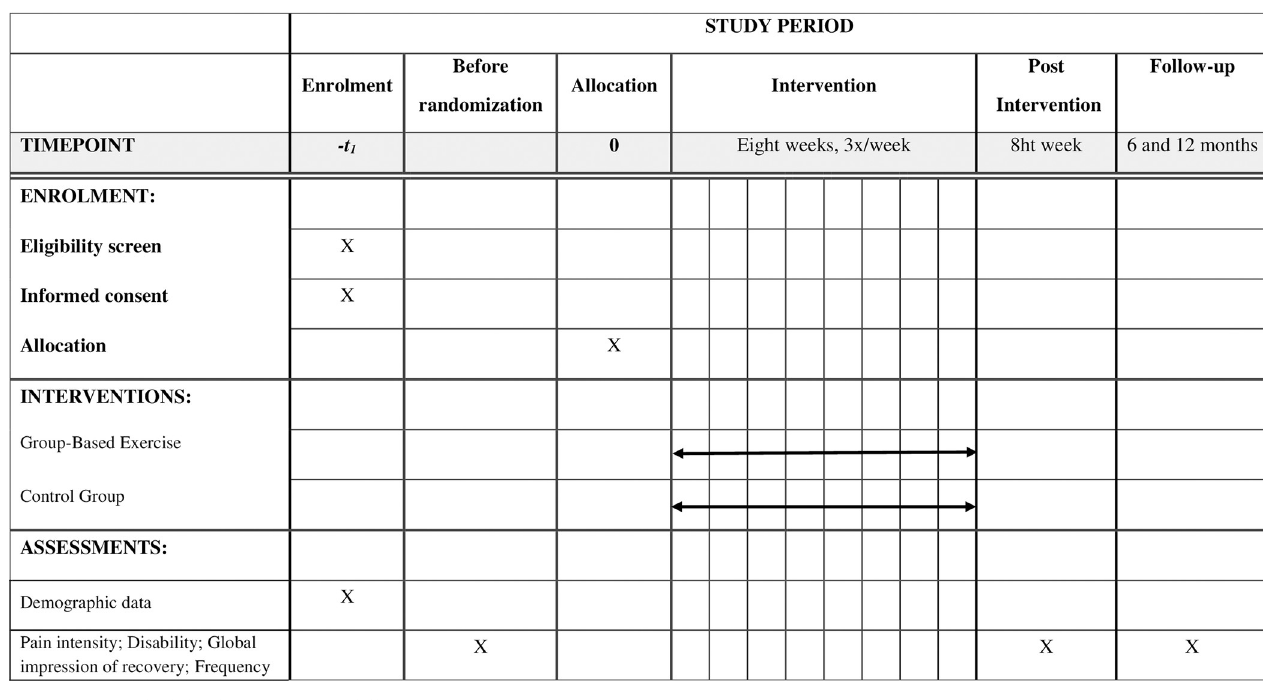
Fig 1. SPIRIT schedule of assessments at different time